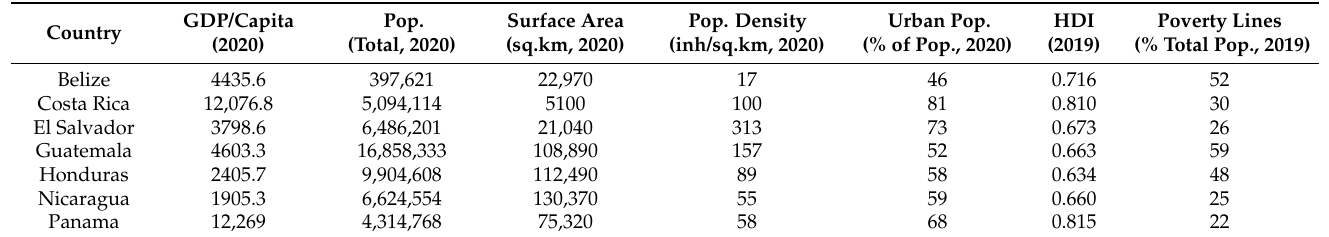
Table 1. Socioeconomic parameters for Central American countries.